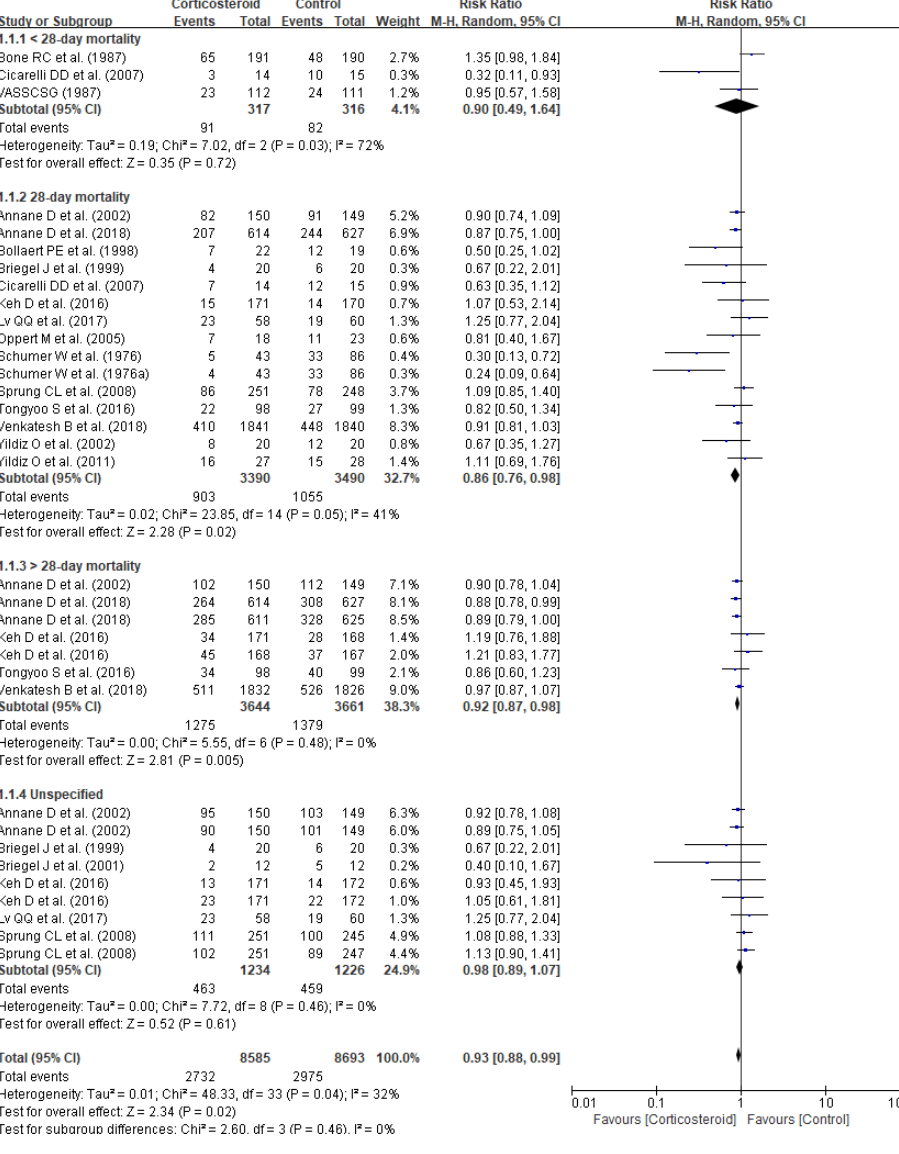
Figure 3. Forest plot of length of stay in hospital and ICU.